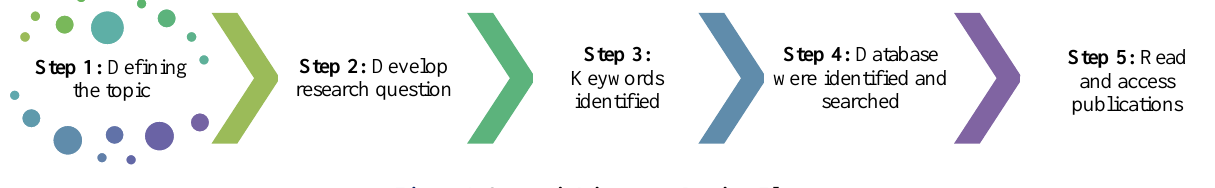
Figure 1. Systemic Literature Review